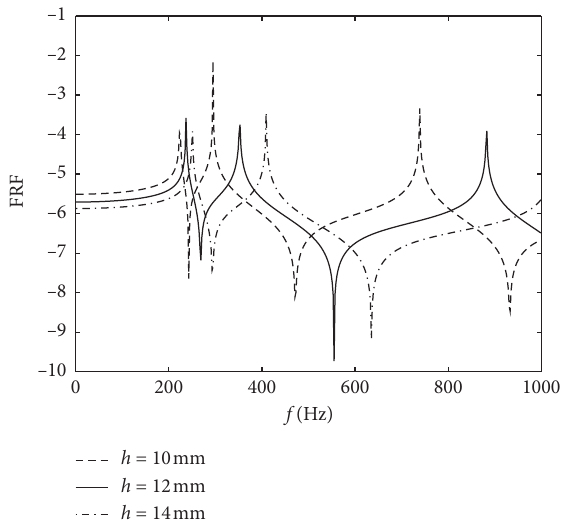
Figure 7: FRF curve for various ellipticities. Figure 6: FRF curve for various